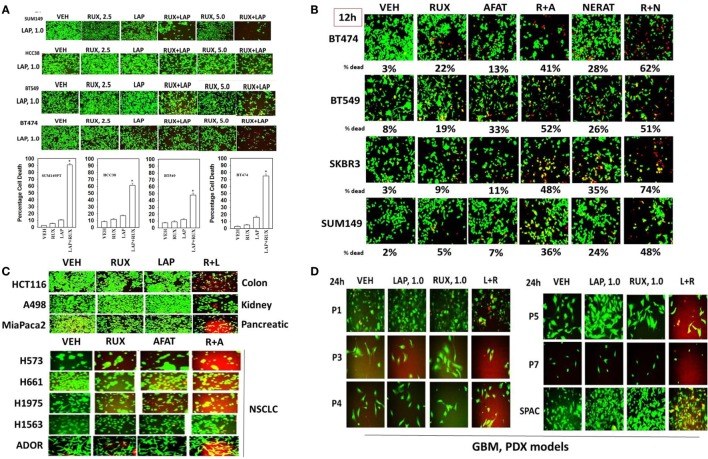
The JAK1/2 inhibitor Ruxolitinib interacts with the ERBB1/2/4 inhibitor Lapatinib to kill breast cancer cell lines that: lack PTEN; over-express ERBB2; and are classified as triple negative. (A) SUM149, BT549, HCC38, and BT474 cells were treated with vehicle control, ruxolitinib-phosphate (2.5/5.0 μM), lapatinib tosylate (1.0 μM) or the drugs in combination. Twenty-four hours later, cell viability was assessed using a live/dead assay in a Hermes WiScan microscope at 10× magnification (n = 3 ± SEM) *p < 0.05 greater than vehicle control. (B) BT474, BT549, SKBR3, and SUM149 cells were treated with vehicle control, ruxolitinib-phosphate (2.5 μM), afatinib (1.0 μM), neratinib (1.0 μM), or the drugs in combination as indicated. Twenty-four hours later, cell viability was assessed using a live/dead assay in a Hermes WiScan microscope at 10× magnification (n = 3 ± SEM). (C) HCT116 (colon); A498 (renal); Mia Paca2 (pancreatic) and multiple NSCLC lines including the July 2015 PDX isolate ADOR; cancer cells were treated with vehicle control, ruxolitinib-phosphate (2.5 μM), lapatinib (2.0 μM) or the drugs in combination as indicated. (D) Primary human glioblastoma cells (P1-P7) and a PDX model of recurrent medulloblastoma (SPAC) cancer cells were treated with vehicle control, ruxolitinib-phosphate (1.0 μM), lapatinib (1.0 μM) or the drugs in combination as indicated. Twenty-four hours later, cell viability under all conditions was assessed using a live/dead assay in a Hermes WiScan microscope at 10× magnification.